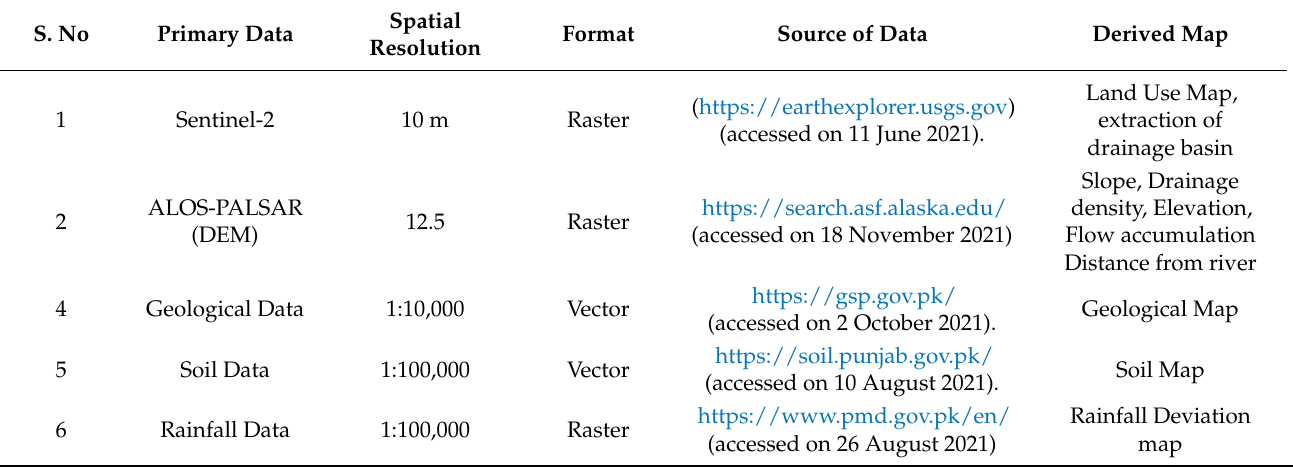
Table 1. The sources from where different data were collected and their purpose of